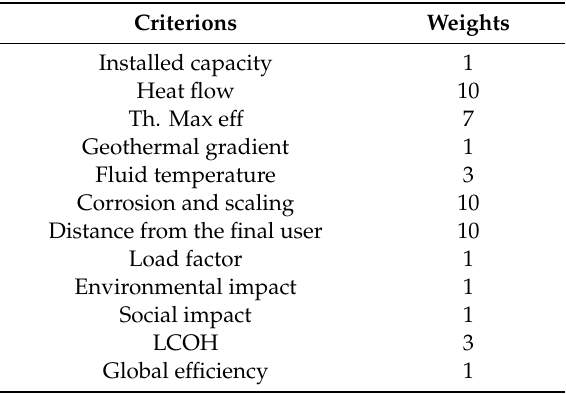
Table 2. Agriculture assigned